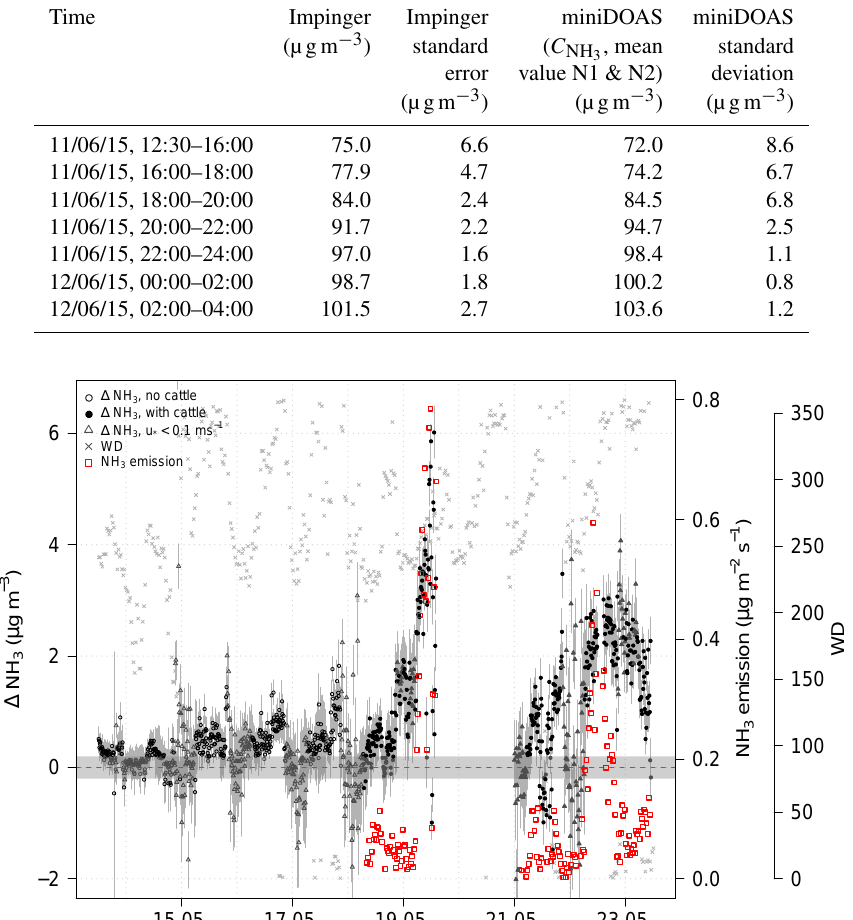
Figure 7. Horizontal NH 3 concentration differences and derived emissions from grazing experiment E4 (Table 1); black/grey open symbols show the period without cattle on the investigated pasture, black/grey filled symbols highlight the period with cattle grazing on subplot or the entire field (see Fig. S1), and red symbols show emissions; concentrations were calculated like in experiment E3; concentration difference uncertainty range (grey lines) represents the maximum limit of 95% confidence. The grey band indicates 0 ± 0.2µgm − 3 (LOD); the data gap was caused by power supply interruption and translocation of